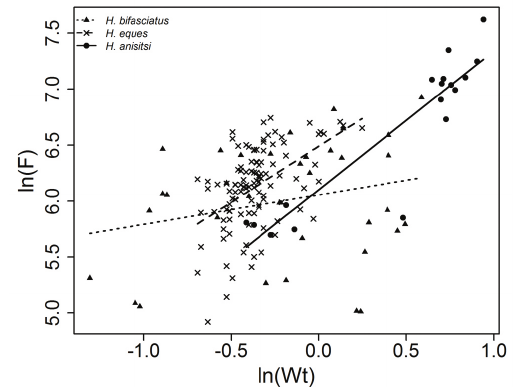
Figure 2. Relationships between fecundity (F), and total weight (W ), for Hyphessobrycon bifasciatus , H . eques , and t H . anisitsi . The parameters of the linear regressions are presented in Table 2.